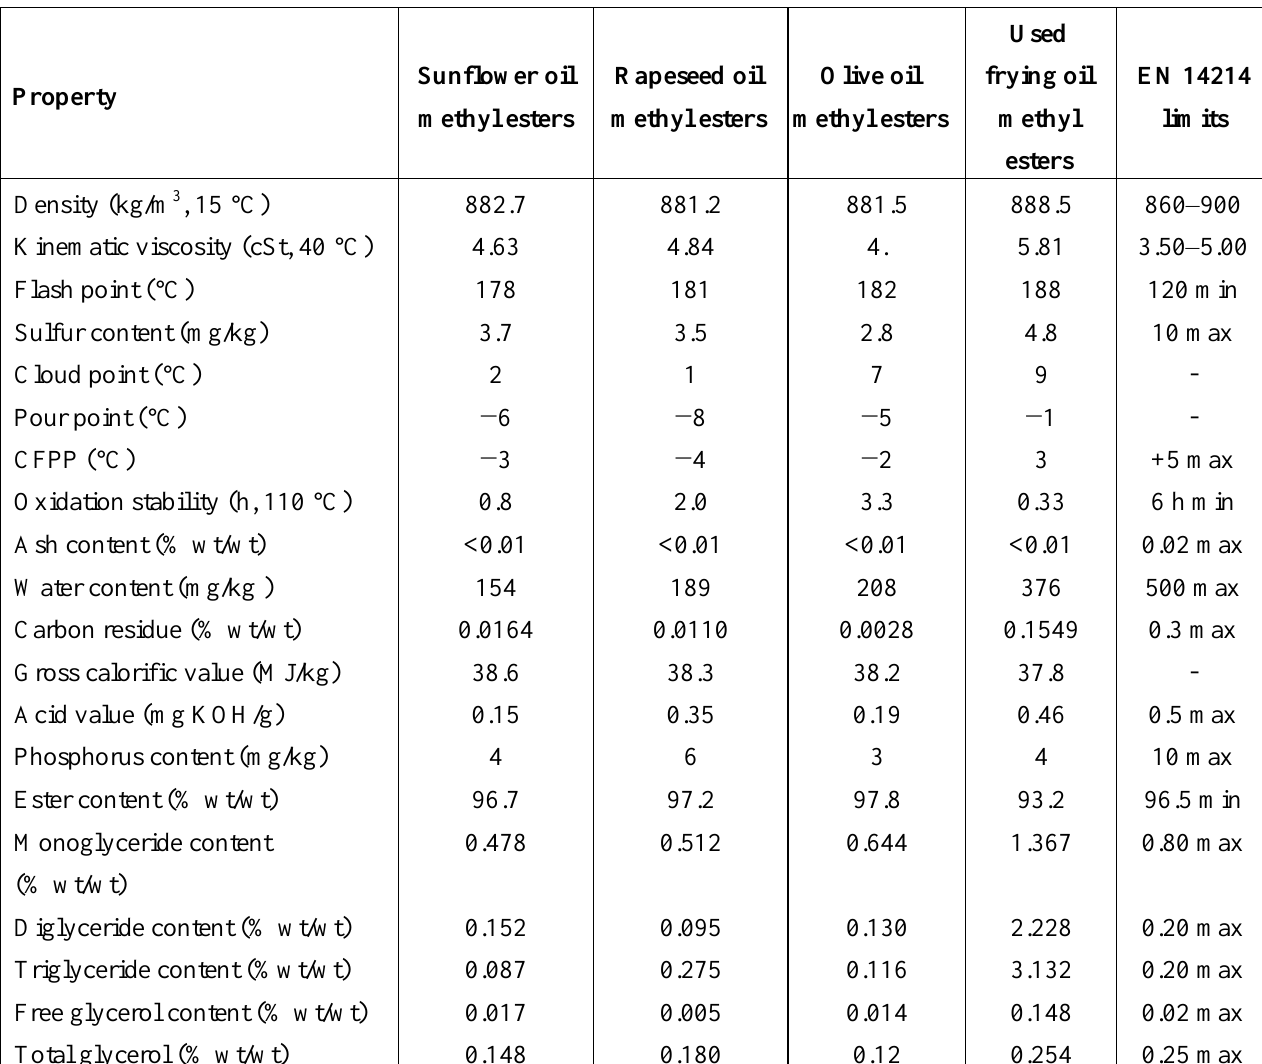
Table 2. Properties of fatty acid ethyl